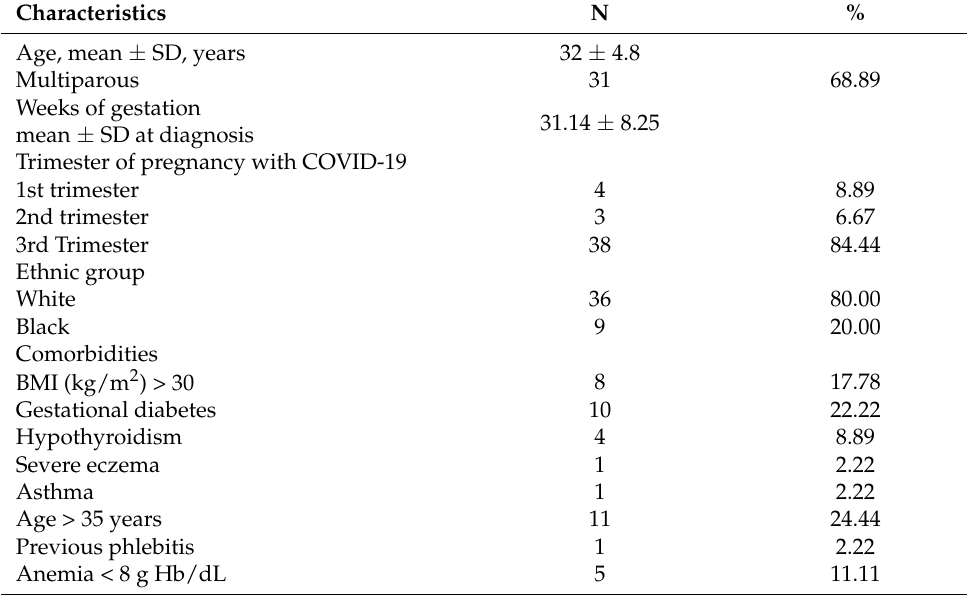
Table 1. General characteristics of pregnant women with coronavirus disease (COVID-19).